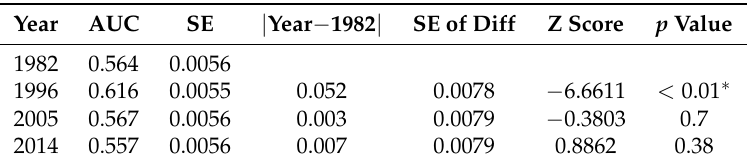
Table 1. Comparison of AUCs across four years based on Wilcoxon statistic. The ∗ symbol denotes the AUCs are significantly different with p -value less than